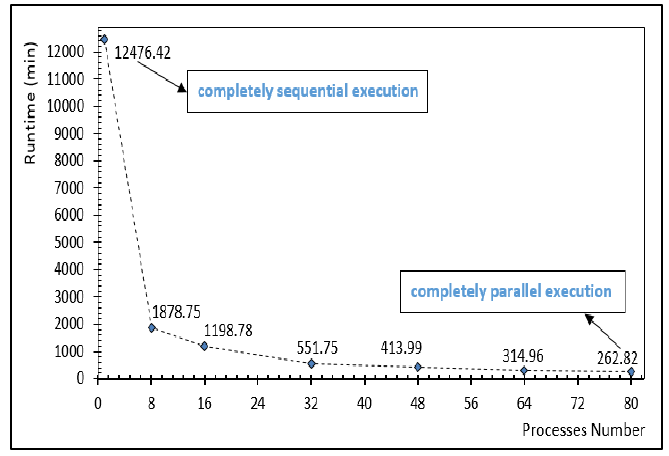
Figure 14. Program runtimes according the number of cluster nodes used (each process per